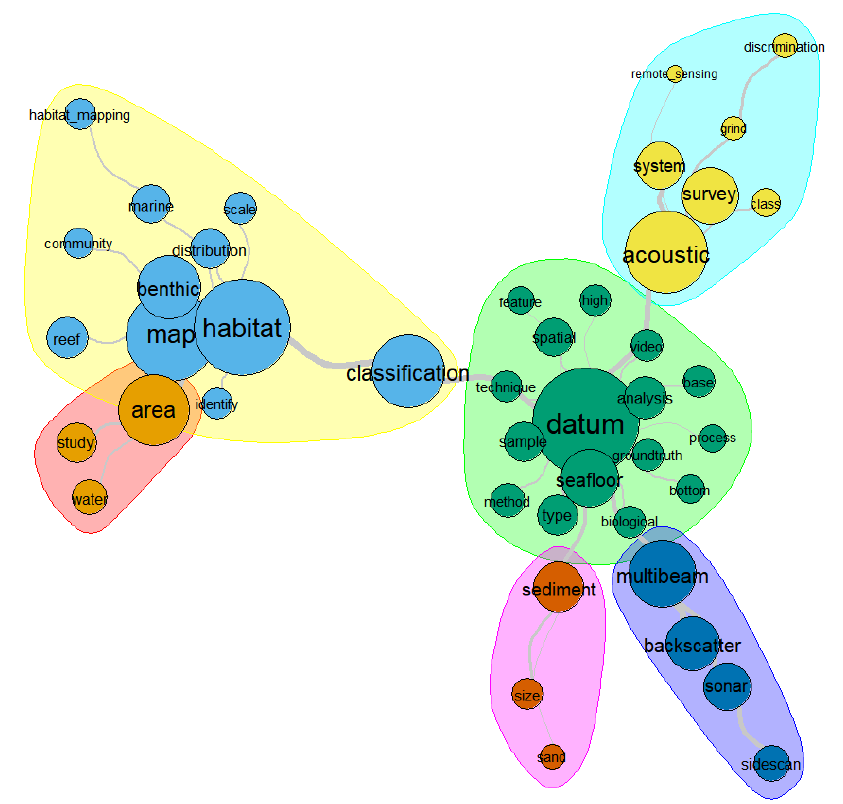
Figure 6. Graph of the similarity among the more frequent terms in the decade of 2000–2010. Note that colors do not represent a specific similarity value. Colors are used to clearly represent the word clustering. The bigger the word font and the associated circle, the higher is the frequency of appearance of that word. The thickness of the grey roots connecting the words represents the frequency that two words appear close to each other, i.e., the co-occurrence among the words. Thicker roots mean higher frequency.